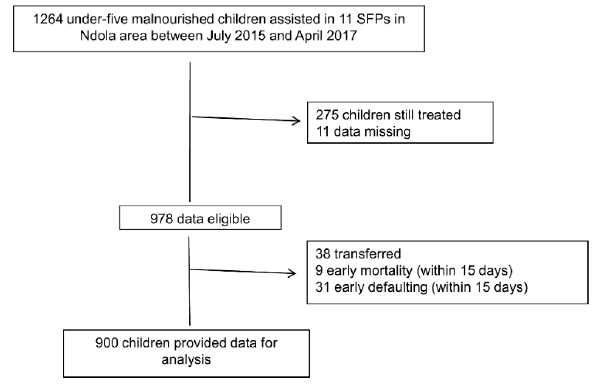
Figure 1. The study flowchart.